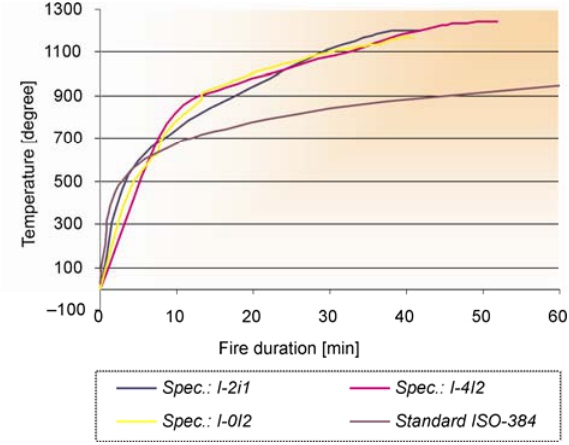
Fig 7 . Furnace heating regime during the 1 st stage or the test type II.1